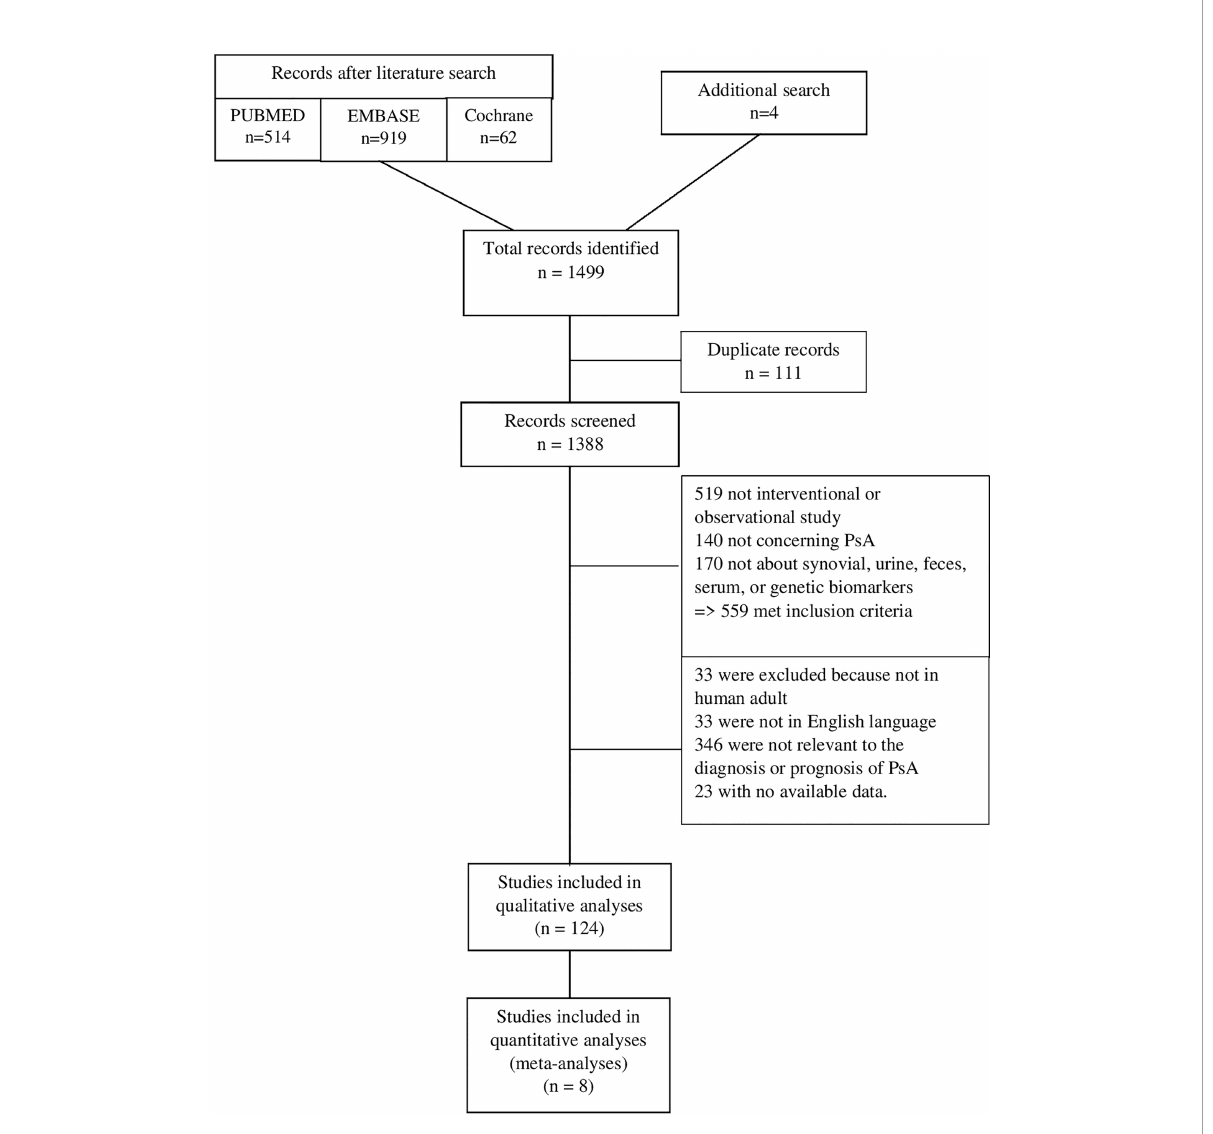
FIGURE 1 Flowchart of the study